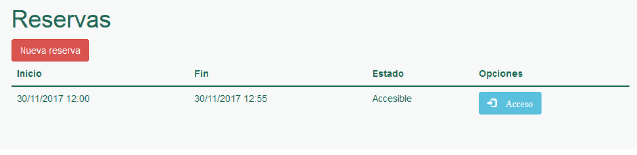
Figure 1. Booking a session in the security lab.